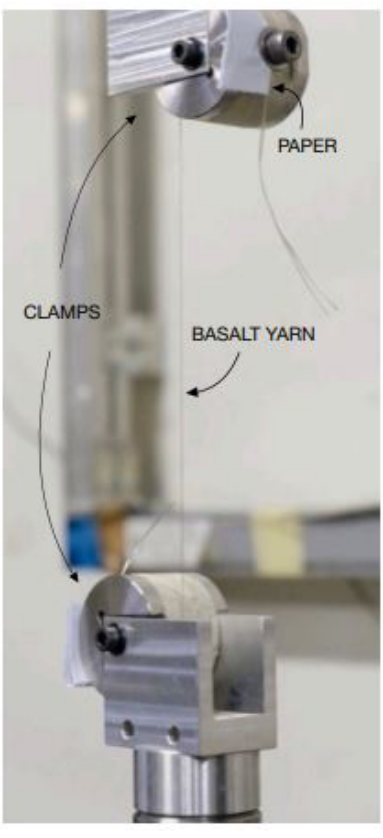
Figure 6. Tensile test